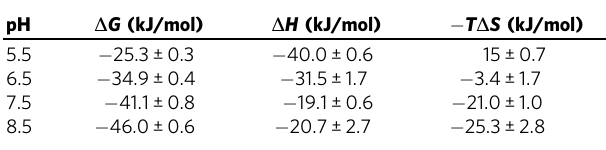
Table 3 pH-dependent binding parameters determined by